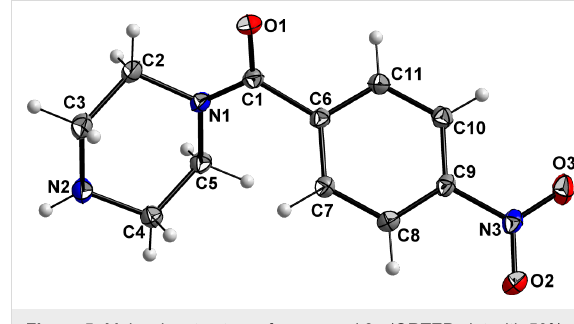
Figure 5: Molecular structure of compound 3a (ORTEP plot with 50% probability level).